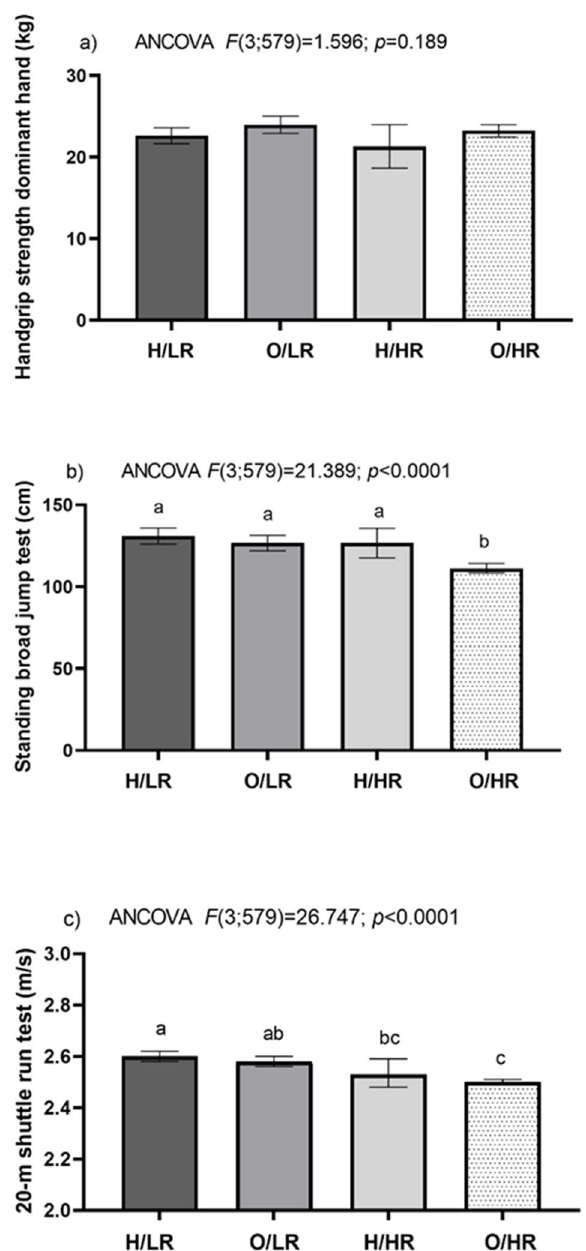
Figure 1. Physical fitness according to sub-classification of obesity. Healthy BMI/low-risk WtHr (H/LR); Overweight and obese/low-risk WtHr (O/LR); Healthy BMI/high-risk WtHr (H/HR); and Overweight and obese/high-risk WtHr (O/HR). In the same row, abc different lowercase letters indicate statistically significant differences between groups (Bonferroni post hoc). n = 583.